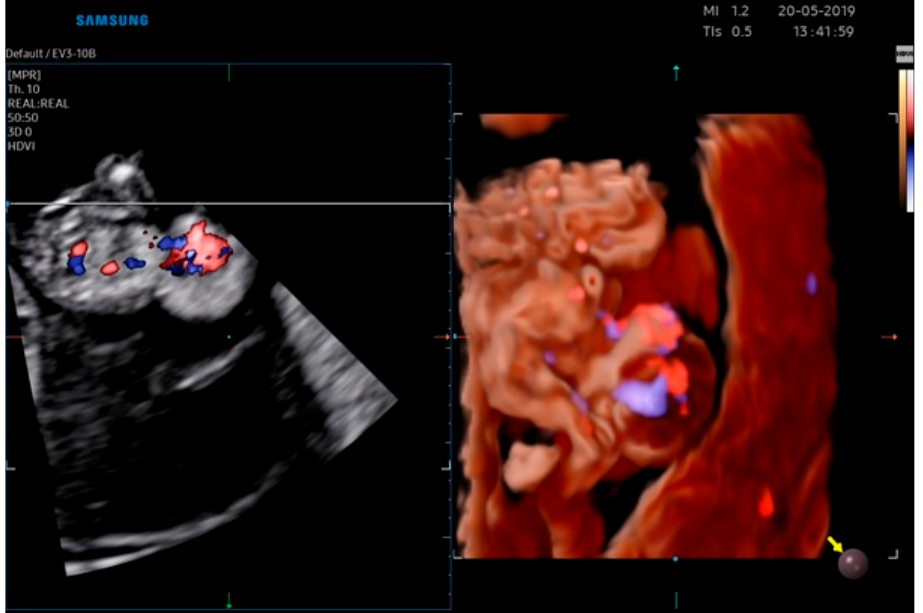
Figure 4. Realistic Vue image of case report 2 at 13 weeks.